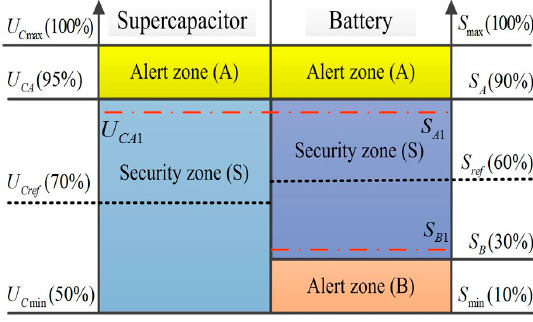
Figure 9. SOC regions of energy storage components.